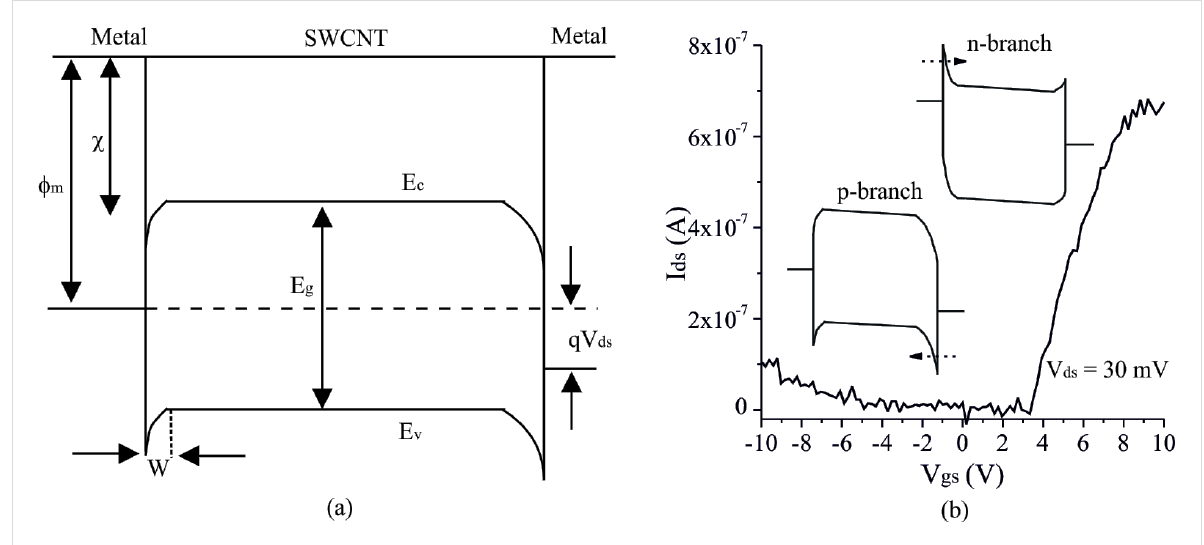
Figure 3: The energy band diagram of a CNFET. a) The band bending effect at the metal–SWCNT interface for a metal with a low work function. A positive voltage bias is applied between drain–source electrodes and the gate bias is set to zero. b) The transfer characteristics of an n-type CNFET. Inset sketches show the Schottky barrier width modulation with respect to the different bias conditions from the gate electrodes.